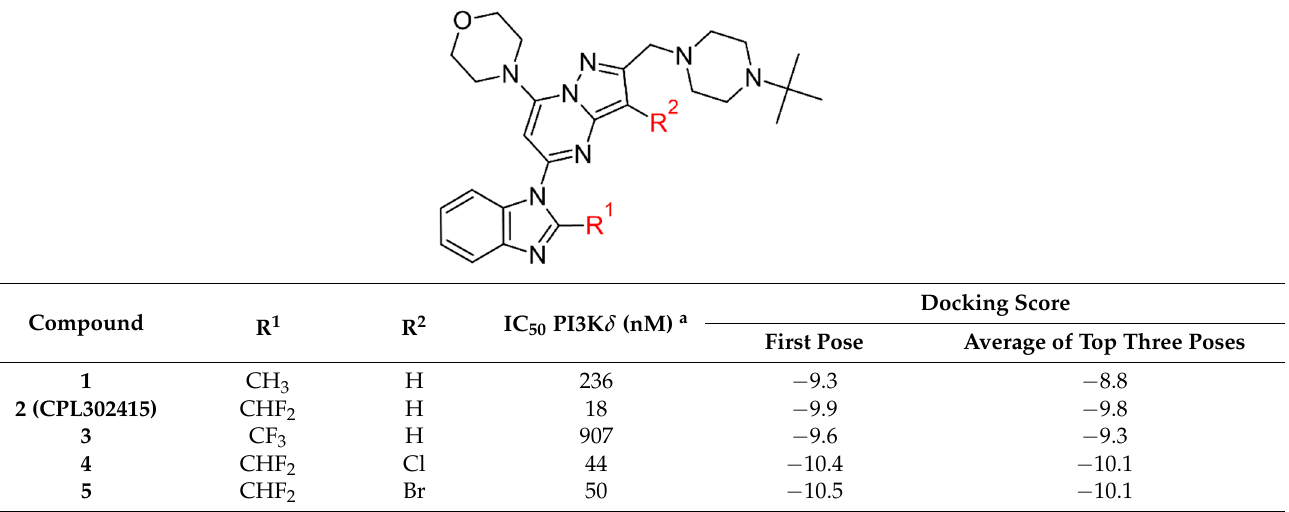
Table 1. Influence of the fluorine atom(s) on PI3K δ inhibition and the respective docking scores for each derivative.